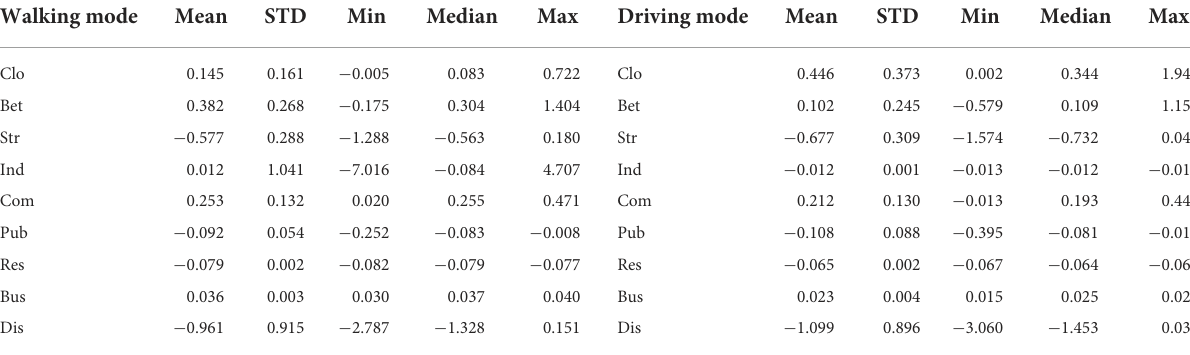
TABLE 5 Statistical description of the coefficients of each variable in MGWR. Walking